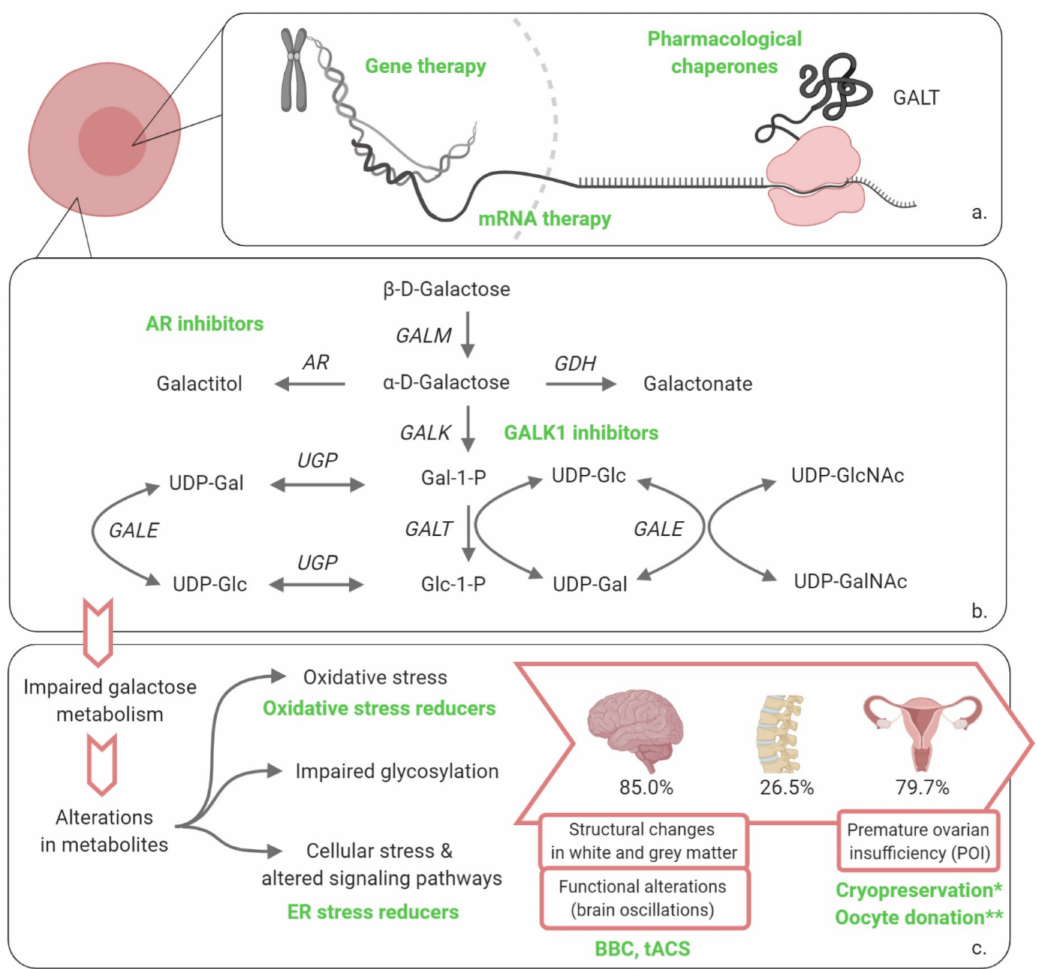
Figure 1. Overview of disorders of galactose metabolism and novel therapeutic approaches recently investigated or under investigation for classic galactosemia. ( a ) Transcription and translation leading to the production of enzyme, therapies restoring enzyme activity; ( b ) Leloir pathway of galactose metabolism and alternative routes of galactose disposal; ( c ) impaired galactose metabolism leading to long-term organ damage. * cryopreservation: more data have become available in the last 5 years; ** oocyte donation: recommendations for CG regarding this procedure have been formulated by a group of experts in the last 5 years. GALM, galactose mutarotase; GALK1, galactokinase 1; Gal-1-P, galactose-1-phosphate; GALT, galactose 1-phosphate uridylyltransferase; Glc-1-P, glucose-1-phosphate; GALE, UDP-galactose 4 (cid:48) -epimerase; UDP-Gal, uridine diphosphate-galactose; UDP-Glc, uridine diphosphate-glucose; UGP, UDP-glucose pyrophosphorylase; UDP- GlcNAc, UDP- N -acetylglucosamine; UDP-GalNAc, UDP- N -acetylgalactosamine; AR, aldose reductase; GDH, galactose dehydrogenase; ER, endoplasmic reticulum; BBC, Babble Boot Camp; tACS, transcranial alternating current stimulation. Created with